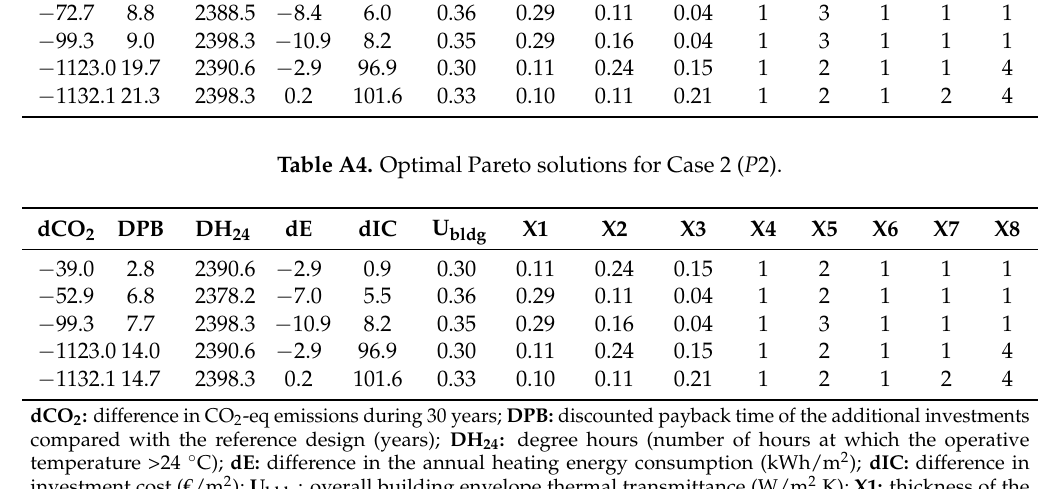
X7: building tightness (Table 7); X8: heating system type (Table